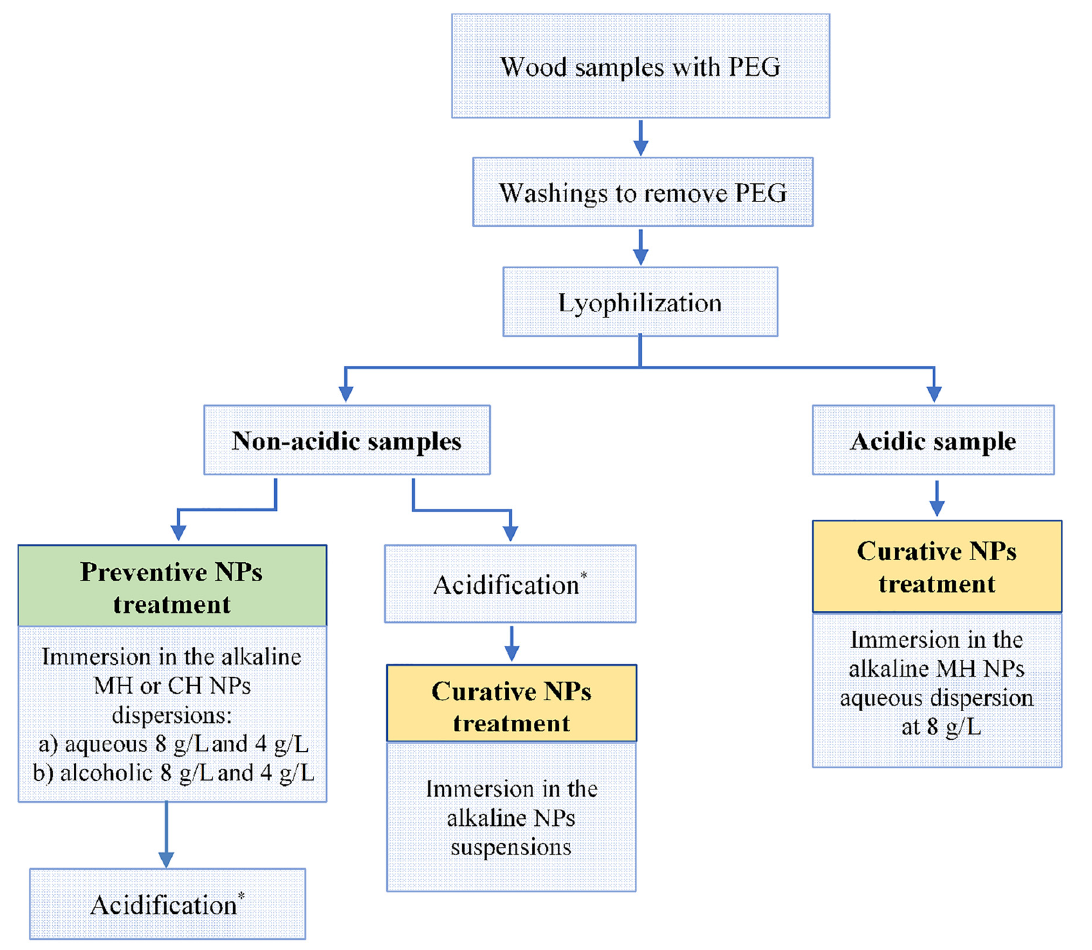
Figure 3. Scheme of the procedures followed for preventive and curative treatments of the Gallo- Roman wreck samples containing the acid precursors (iron and sulfur). * Acidification: hydrothermal ageing of the wood samples carried out at T = 80 ± 2 °C and relative humidity (RH) = 80% ± 5%, for 48